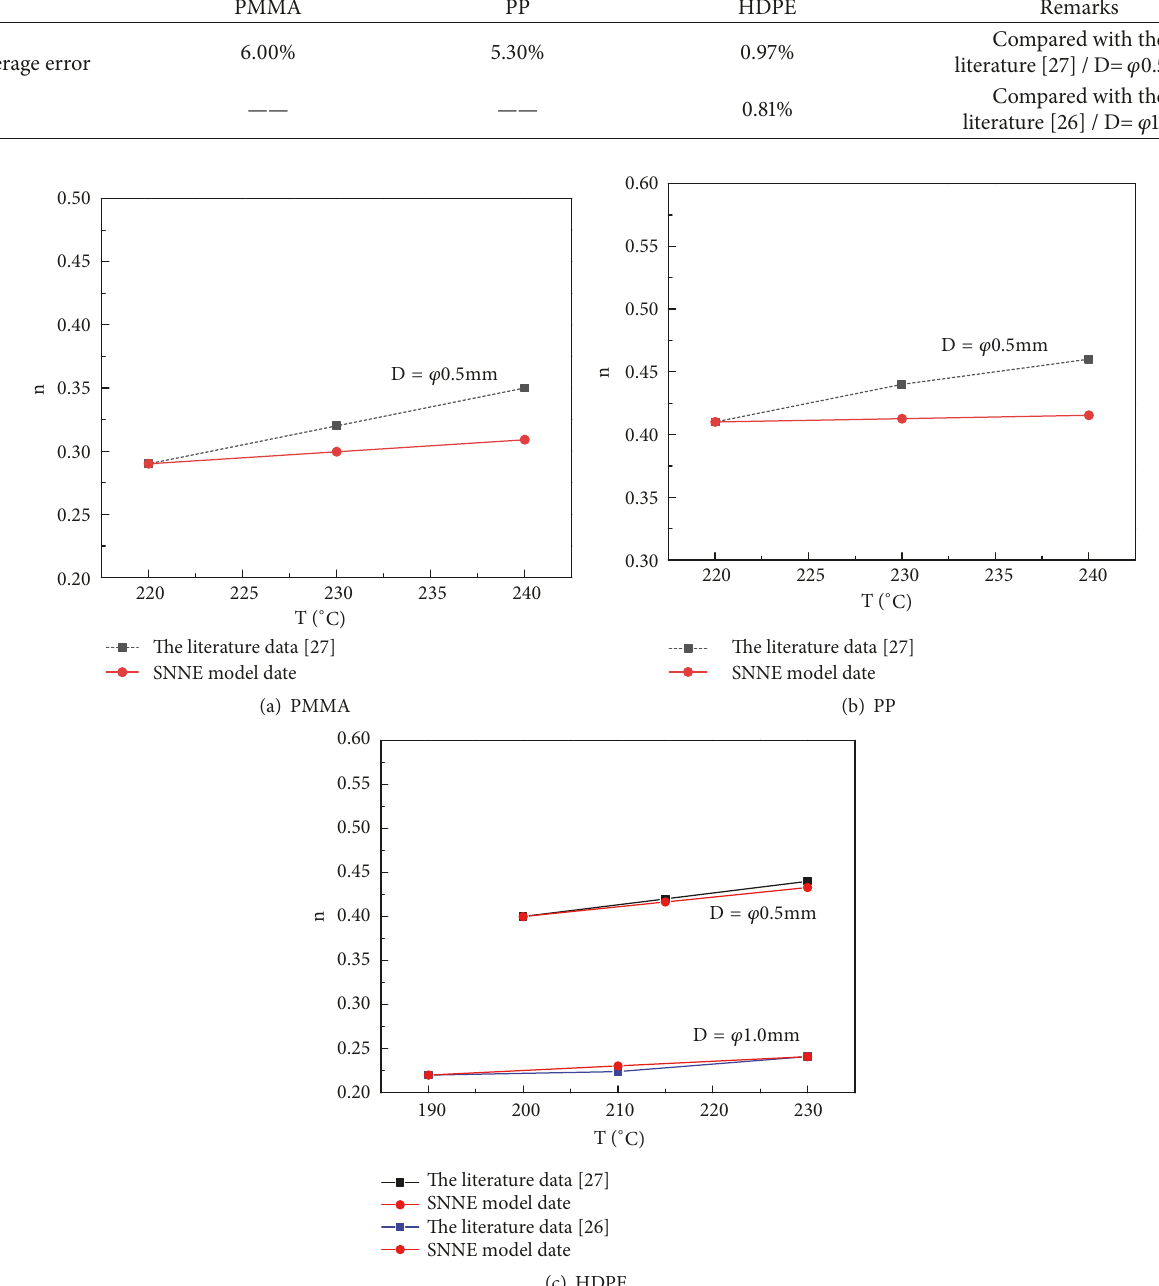
(2) The non-Newtonian index of the three polymer mate- rials is decreased with the feature size within the microscopic scale, while it increases or does not change with the feature size within the macroscopic